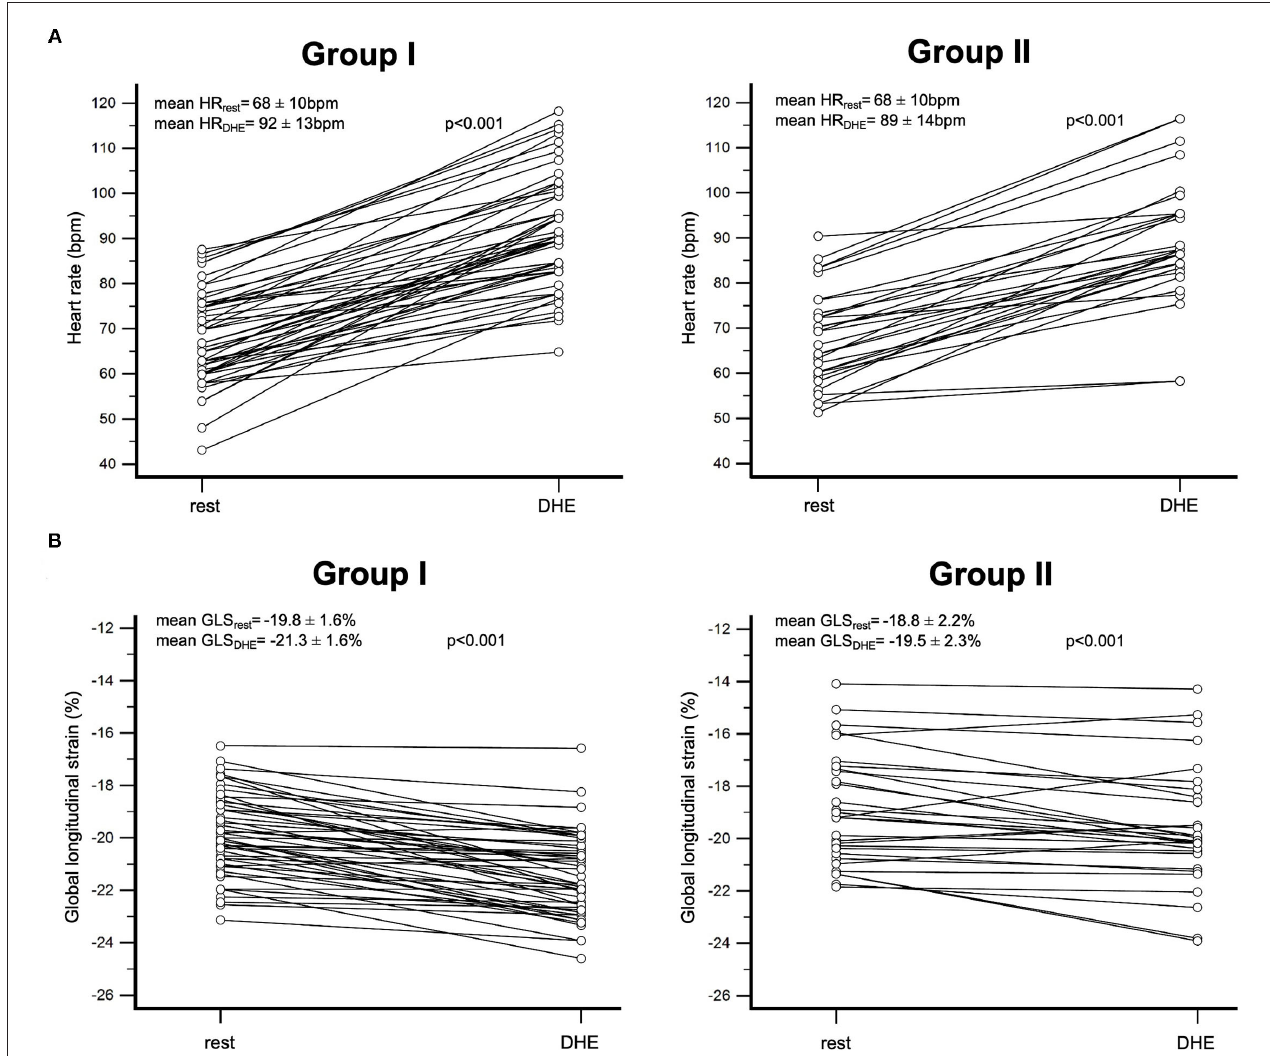
FIGURE 4 | (A) Individual response of HR after DHE in healthy individuals (left) and patients with CAD (right). All individuals showed an increase of HR after DHE. Mean HR of all individuals increased from 68 ± 10 bpm at rest to 91 ± 13bpm after DHE (p < 0.001). (B) Individual response of GLS after DHE in healthy individuals (left) and patients with CAD (right). In 70% of our study population, GLS significantly increased ( 1 GLS < − 0.5%), in 25% it remained unchanged ( 1 GLS ≥ − 0.5% and ≤ 0.5%) and decreased ( 1 GLS > 0.5%) in 5% of patients. Mean GLS increased from − 19.4 ± 1.9% at rest to − 20.6 ± 2.1% after DHE (p < 0.001). HR, heart rate; LS, longitudinal strain; GLS, global longitudinal strain; DHE, dynamic handgrip exercise; CAD, coronary artery disease.